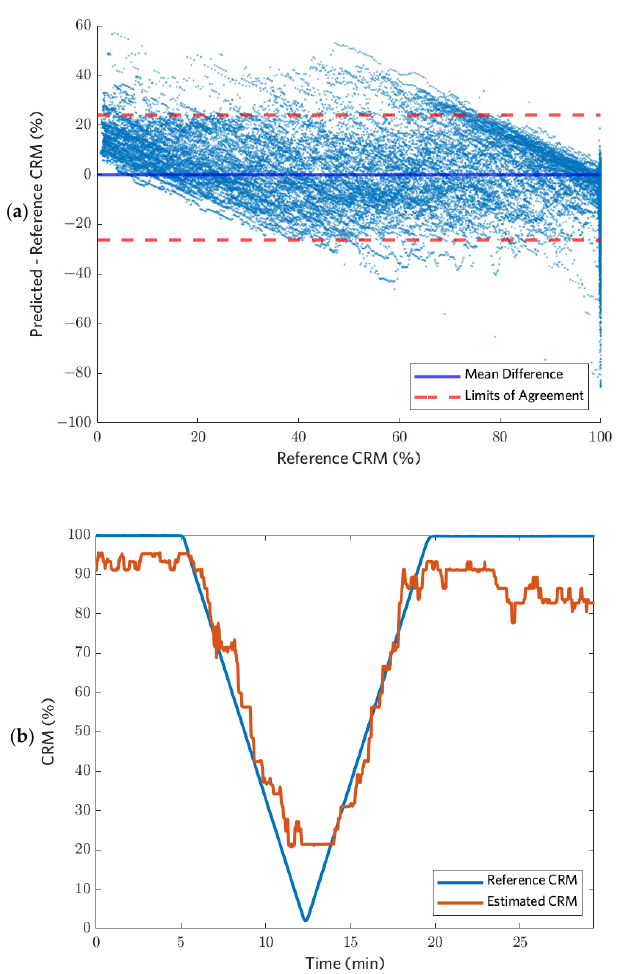
Figure 5. ( a ) A BA plot is shown for the GB tree model trained using all features without baseline normalization for all subjects, and ( b ) Sample reference CRM and estimated CRM using a GB tree model trained with only the HRDN feature from subject 4 without baseline normalization. This example has a lower than average RMSE of 9.9%.